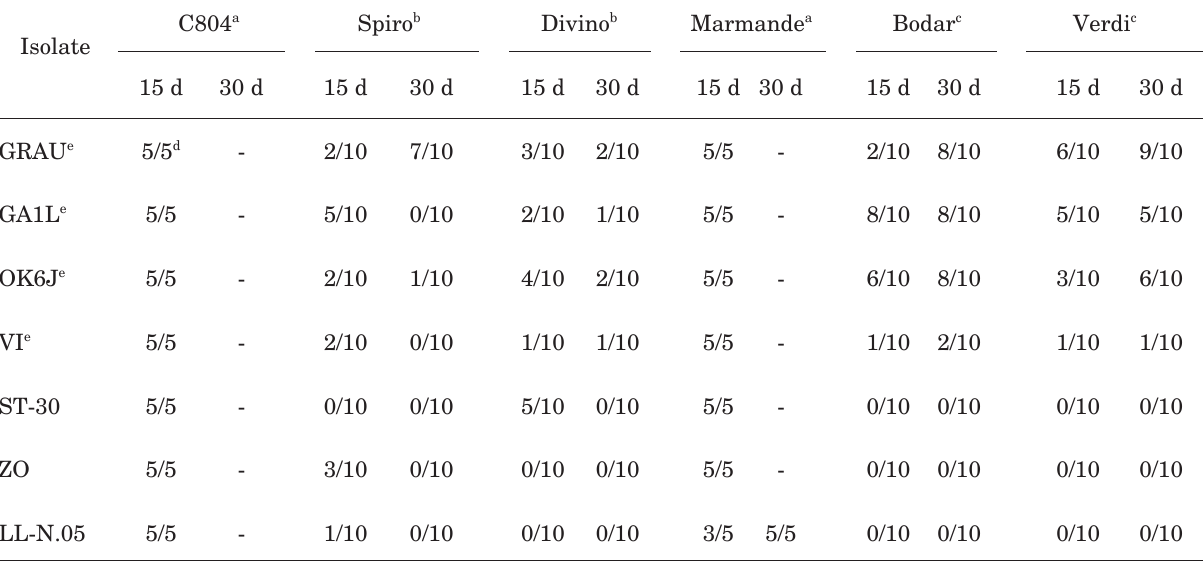
Table 1. Proportion of tomato and pepper plants infected with different Tomato spotted wilt virus (TSWV) isolates determined by enzyme-linked immunosorbent assay, 15 and 30 days after mechanical inoculation.